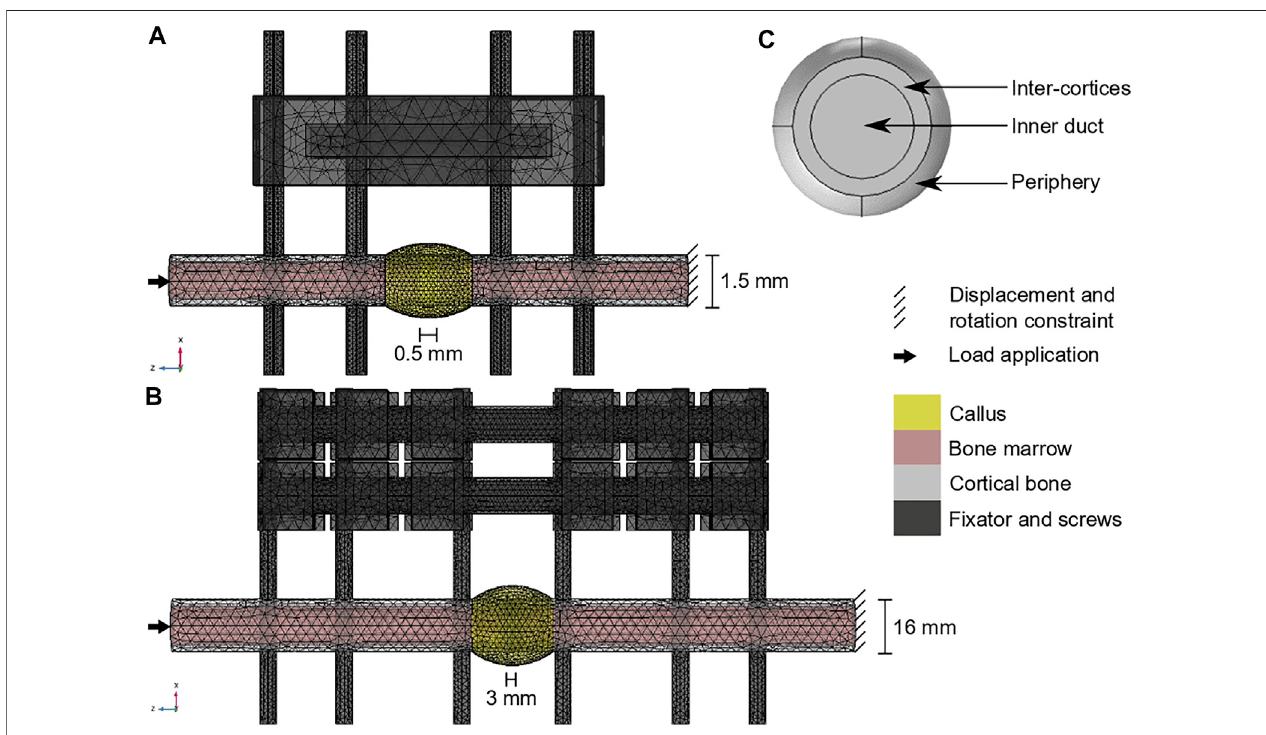
FIGURE2| Computermodel set-ups: (A) Mousefracturehealinggeometry; (B) sheepfracturehealinggeometry; (C) regionofinterestde fi nition inthecallus radial view (shown in yellow on a and b). The color code for (A,B) is given on the right.